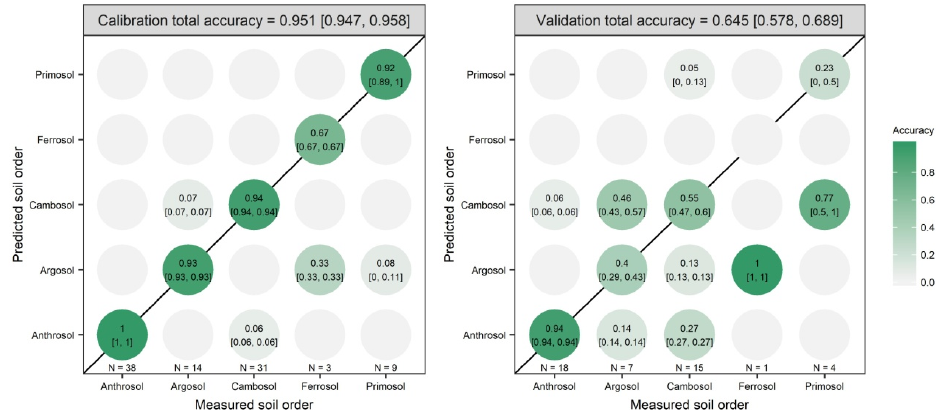
Figure 6. Confusion matrix of soil classification based on MIR spectra.